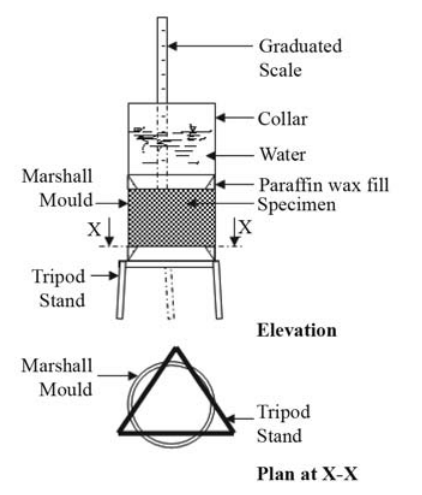
Fig. 4. Typical permeability test setup